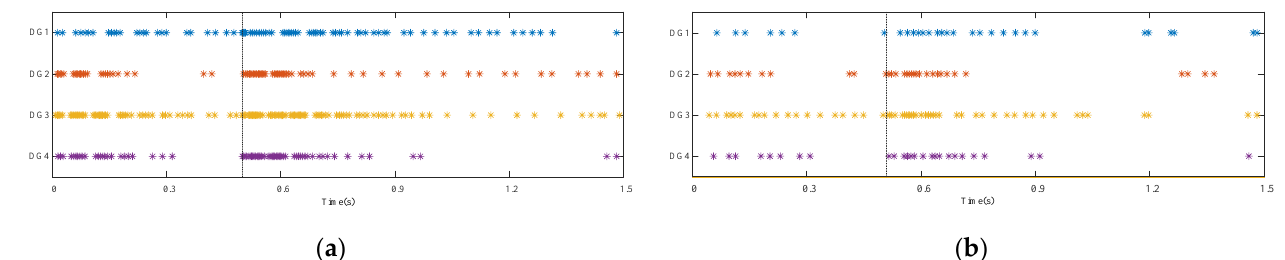
Figure 7. Voltage trigger state diagrams for each DG.